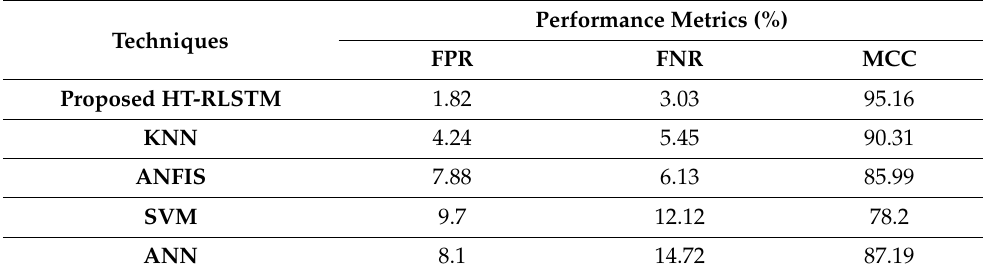
Table 3. Performance analysis of proposed HT-RLSTM with respect to FPR, FNR, and MCC.